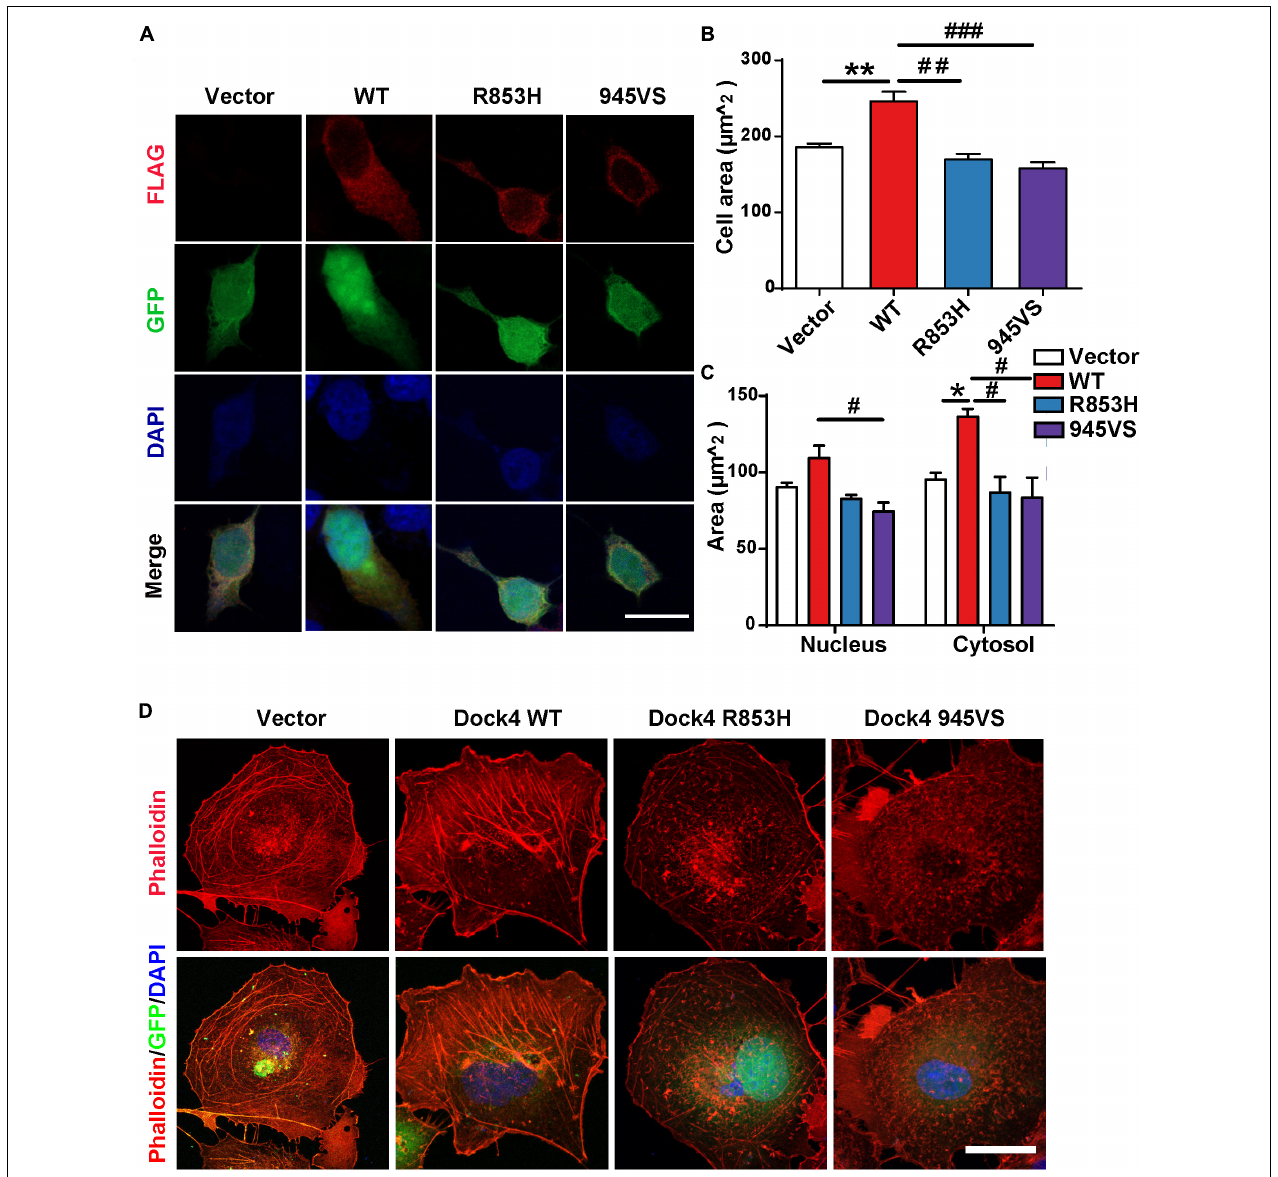
FIGURE 4 | Dock4-R853H and 945VS fail to influence cell morphology. (A) Dock4-R853H, Dock4-945VS, Dock4-WT or vector have different morphology in HEK293T. We transfected HEK293T cells with Vector, Flag-tagged Dock4-WT, Dock4-R853H, Dock4-945VS plasmids. Cells were immunostained using Flag antibody. Scale bar, 20 µ m. (B,C) Total cell area, cytoplasmic area, and nuclear area were measured. Data are shown as mean ± SEM from three independent experiments. ∗ P < 0.05, ∗∗ P < 0.01, # P < 0.05, ## P < 0.01, ### P < 0.001, one-way ANOVA. At least 20 cells/group were analyzed in each experiment. (D) Dock4 R853H and 945VS disrupt actin cytoskeleton in COS7 cells. Cells were immunostained using Phalloidin for visualization of actin cytoskeleton. Scale bar, 50 µ